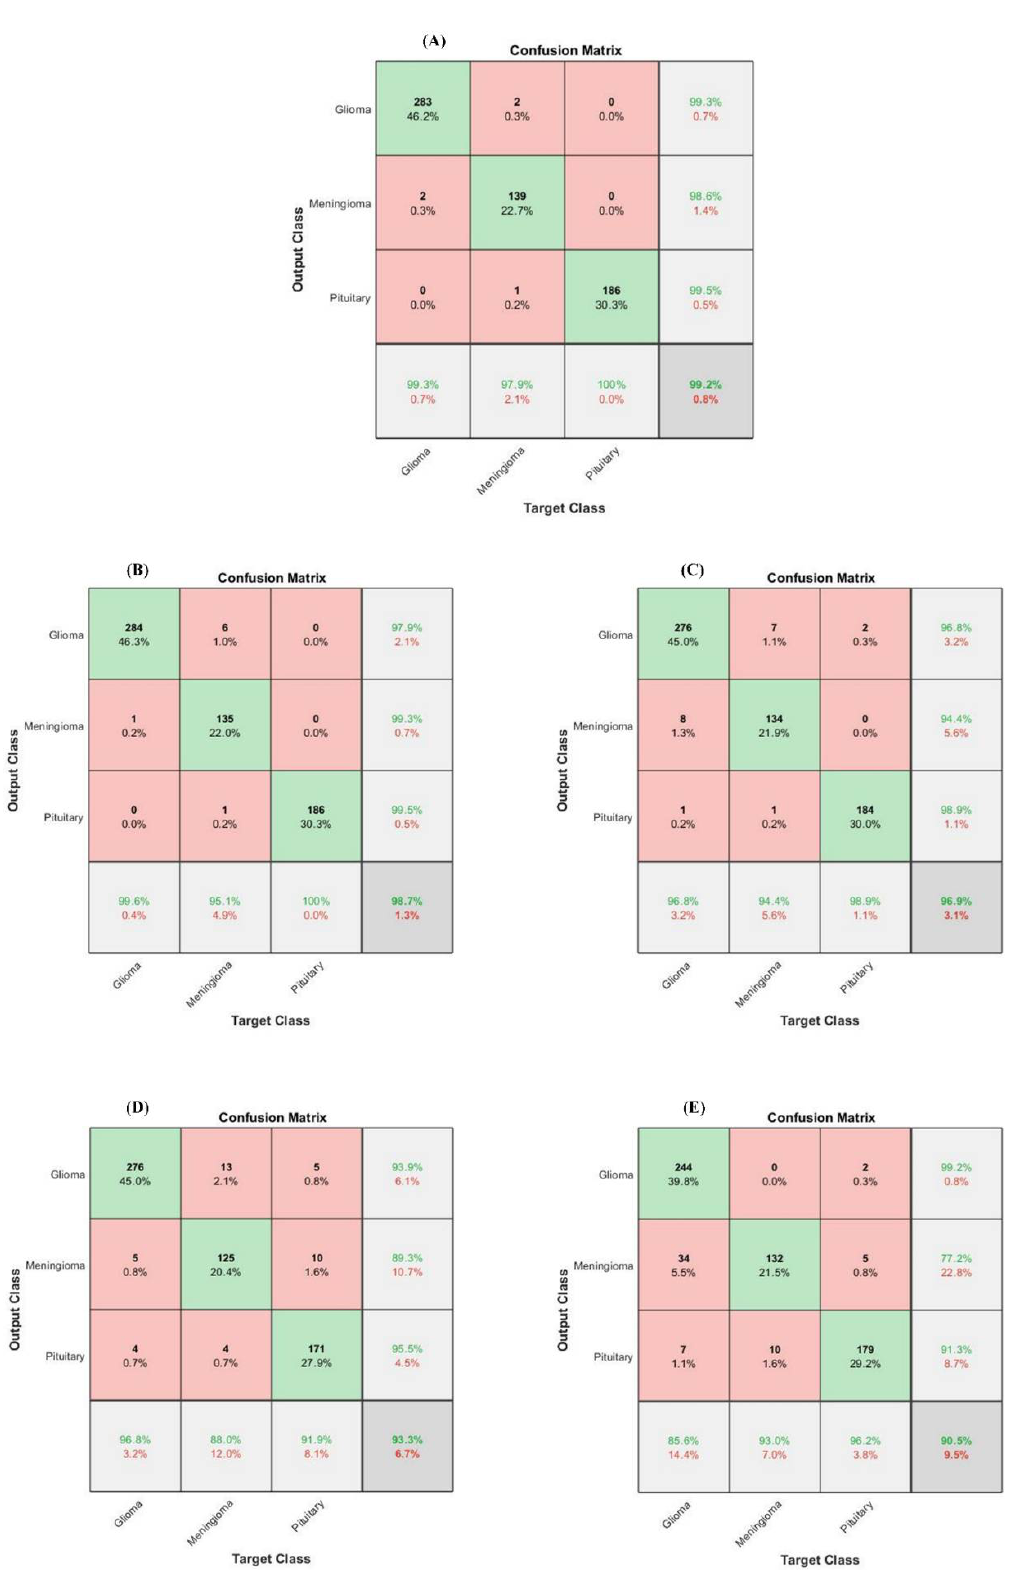
Figure 7. Confusion matrix-based performance comparison of proposed ( A ) HFF-BTC, ( B ) SVM poly. Ordr.2 ( C ) AdaboostM2, ( D ) Decision Tree, ( E ) Naïve Bayes.